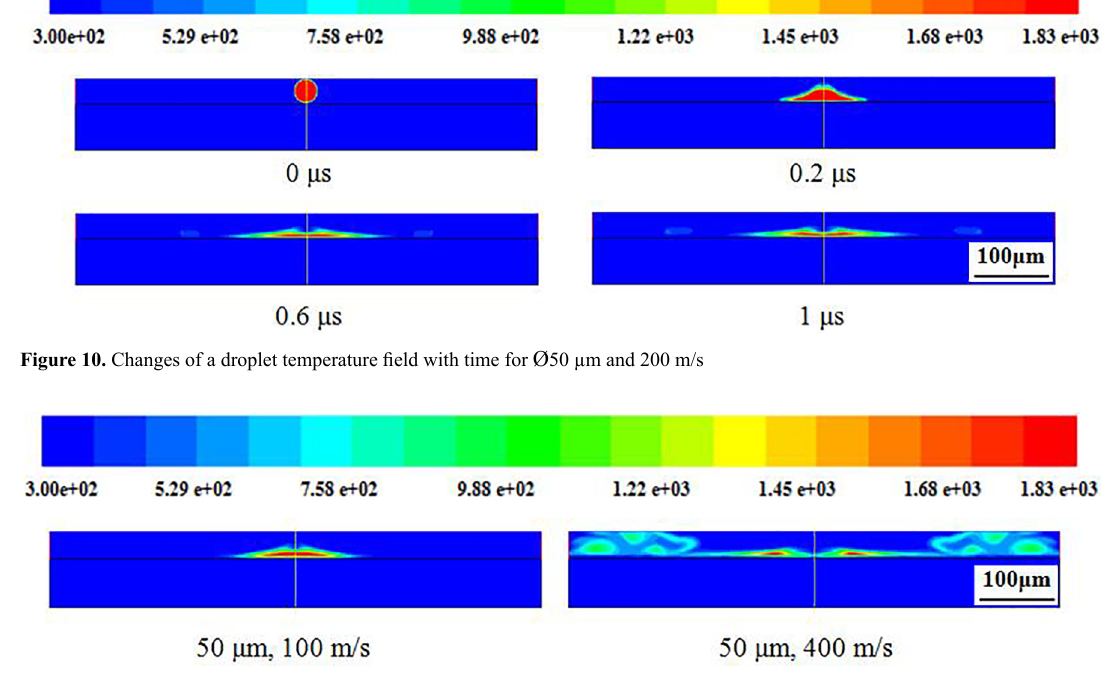
Figure 11. Changes of temperature field with velocity for a droplet diameter of 50 µm and 1 µs